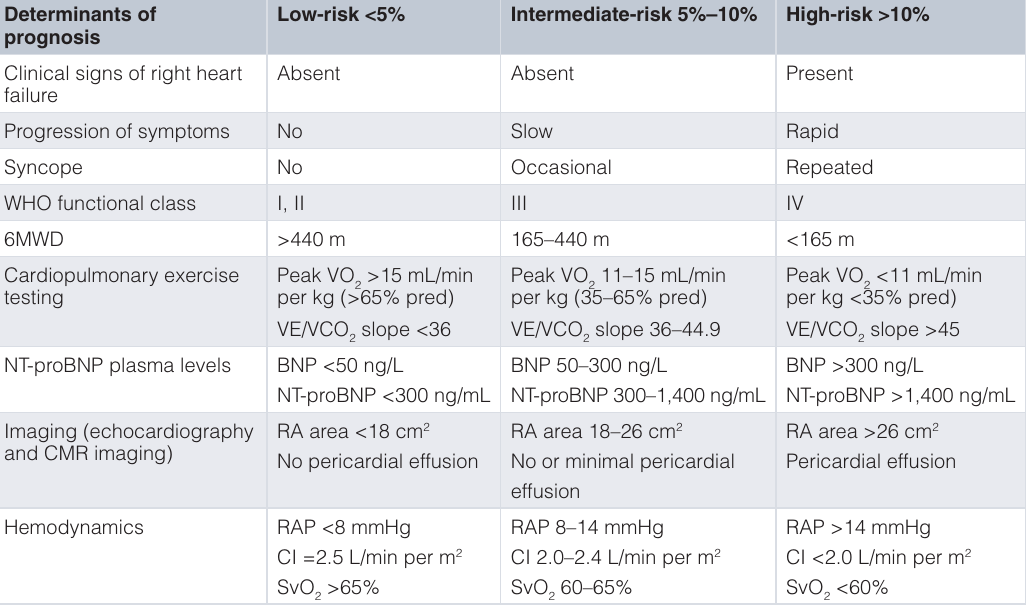
Table 1. Risk assessment in pulmonary arterial hypertension, estimated 1-year mortality.